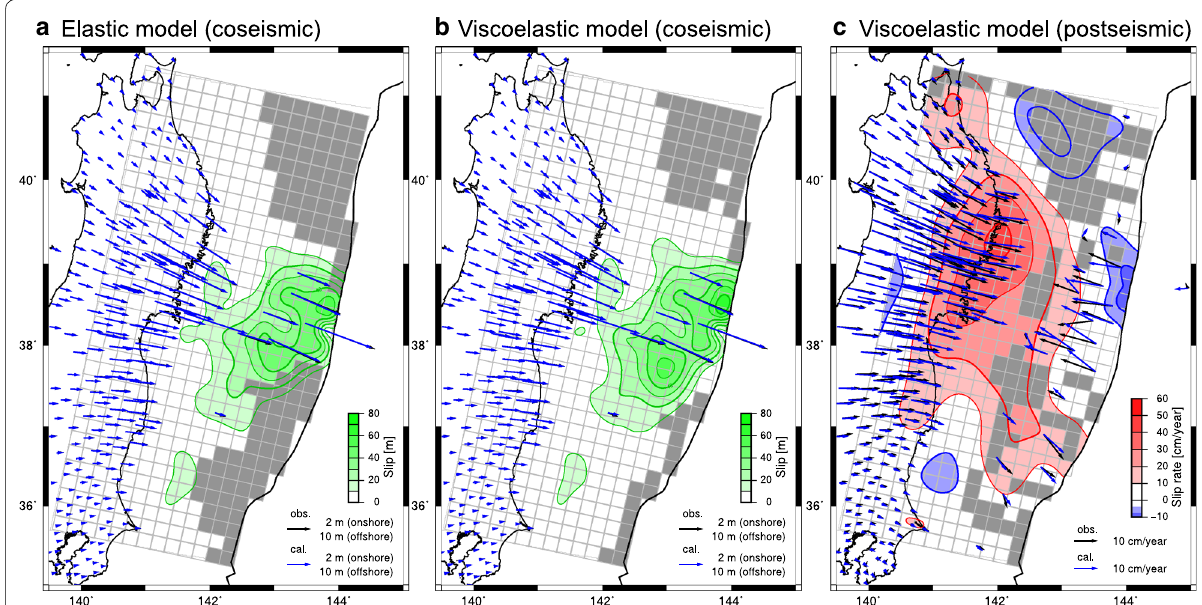
Fig. 11 Co- and post-seismic slip models by the elastic and viscoelastic inversions. a , b The coseismic slip models estimated by the elastic and the viscoelastic inversions, respectively. c The postseismic model in the viscoelastic model. Green contours in a and b show coseismic slip distributions; thin and thick contours are at intervals of 10 m and of 20 m, respectively. Red contours in c show the positive postseismic slip distribution; thin and thick contours are at intervals of 10 cm/year and of 20 cm/year, respectively. Blue contours in c show the negative postseismic slip distribution. Rectangles represent sub-faults used in the slip inversion, and gray rectangles show sub-faults with resolution of < 0.05. Black and blue vectors show the observed and calculated displacements,